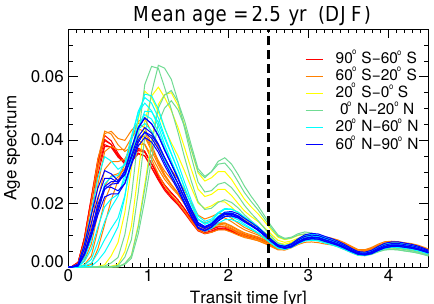
Figure 1. Climatological age spectra for the same mean age of 2.5 years but at different latitude ranges, for December–February. Each line is the average over DJF, with different age spectra of the same colour representing different latitudes within the respec- tive latitude band. The black dashed line highlights the mean age of 2.5